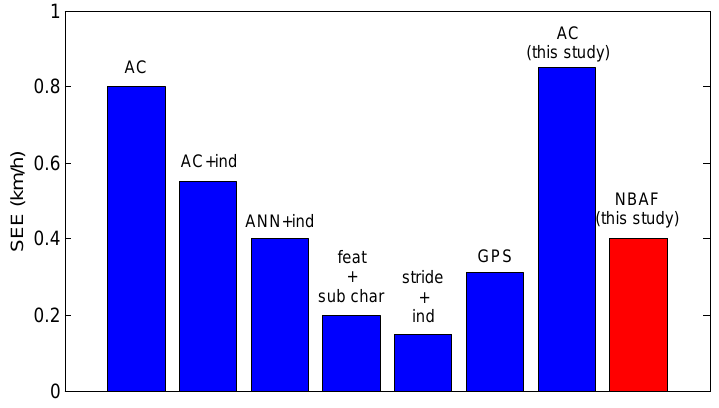
Figure 8. Estimation error of walking speed in the current and previous studies. AC, model based on activity counts [24,25]; AC + ind, model based on activity counts after individual calibration [24,25]; ANN + ind, model based on artificial neural network algorithm after individual calibration [27]; feat + sub char, model based on acceleration features and subject characteristics [9]; Stride + ind, model based on stride characteristics after individual calibration [19]; GPS, model based on GPS data [21,23]; AC, model based on activity counts presented in this study; NBAF, model based on near-body air